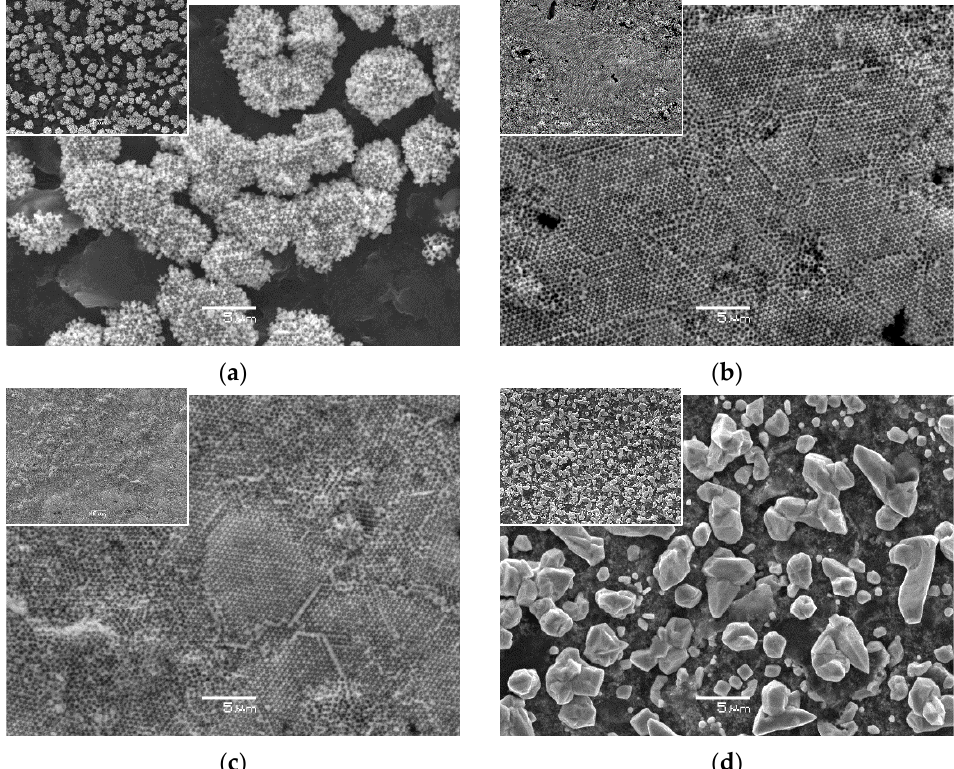
Figure 1. SEM images of pCuFEs prepared using colloidal crystal templating with 500 nm polystyrene spheres, constant current of –1.5 mA, and various times of copper electrodeposition from 0.1 mol L − 1 Cu(II) in 0.01 mol L − 1 HNO 3 (pH 2): ( a ) 30 s; ( b ) 60 s; ( c ) 90 s; ( d ) non-porous Cu film formed without colloidal crystal template after 90 s electrodeposition for comparison (magnification 3000 × , scale bar 5 µ m). Insets are a lower magnification (1000 × , scale bar 10 µ m) of corresponding electrode